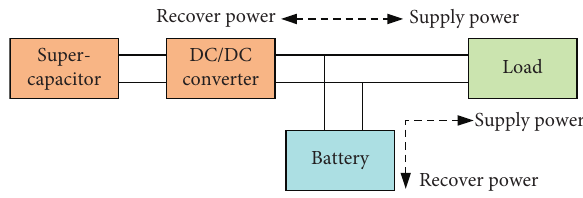
Figure 1: Structure of the semiactive HESS.